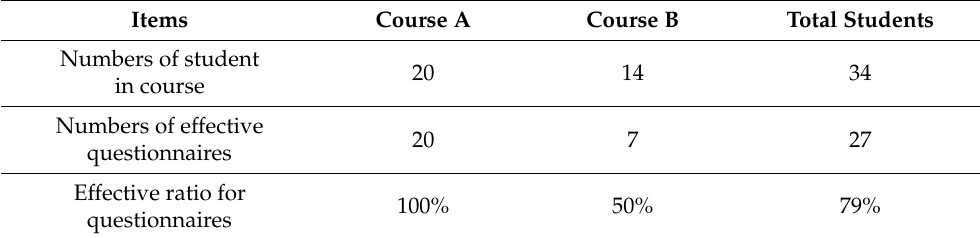
Table 5. Numbers of effective questionnaires.